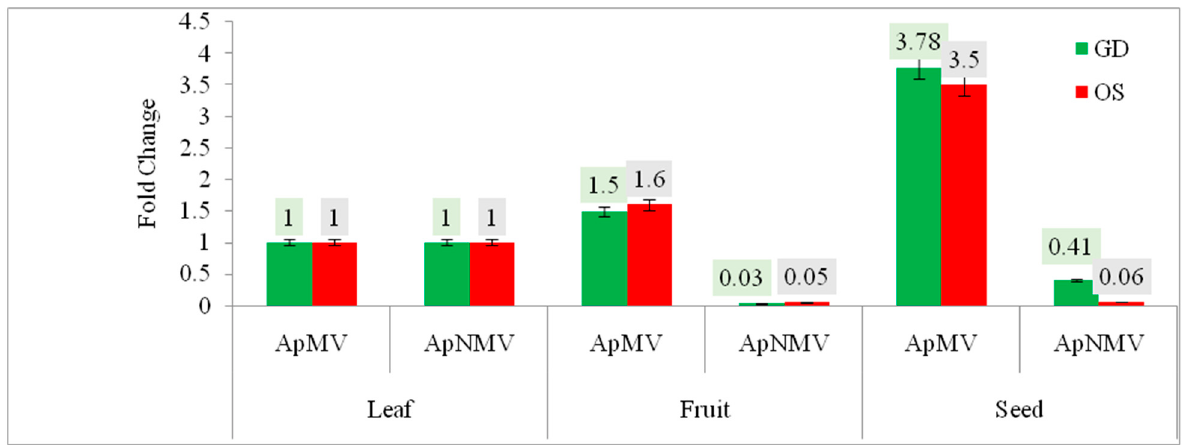
Figure 6. Comparative fold change of the CP gene of ApMV and ApNMV in different tissues in cultivar Golden Delicious (GD) and Oregon spur (OS) during the summer season. Y -axis represents the fold change in the virus infection, whereas X -axis represents different tissues tested for both viruses.